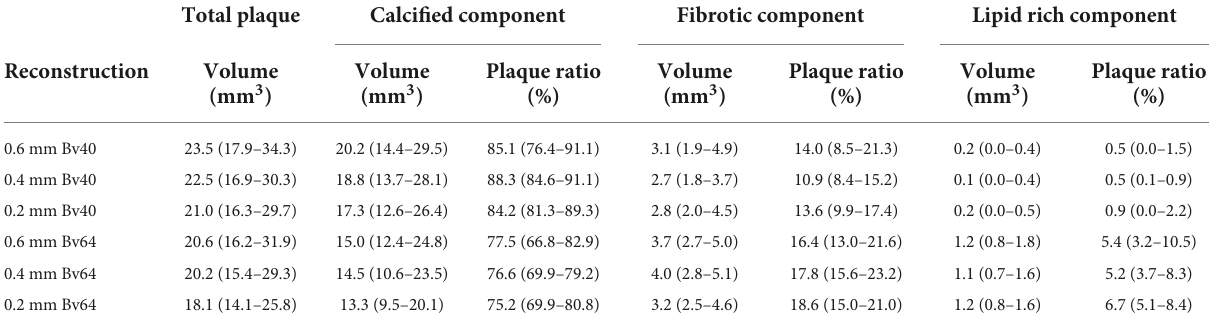
TABLE 2 Results of quantitative plaque analysis.